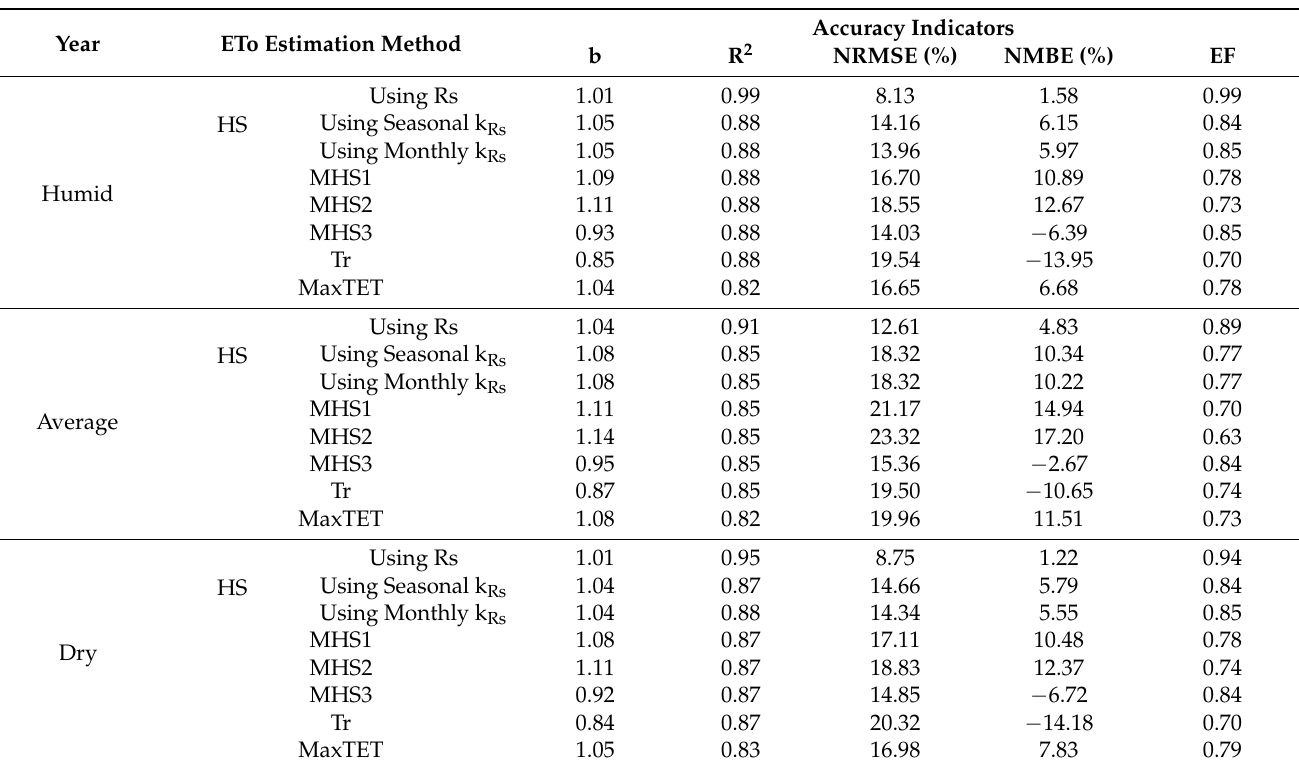
Table 3. Accuracy indicators for the relationship between daily ETo estimated by the Penman–Monteith equation, by the temperature-based equations for Beja and for three different years–humid, average and dry.